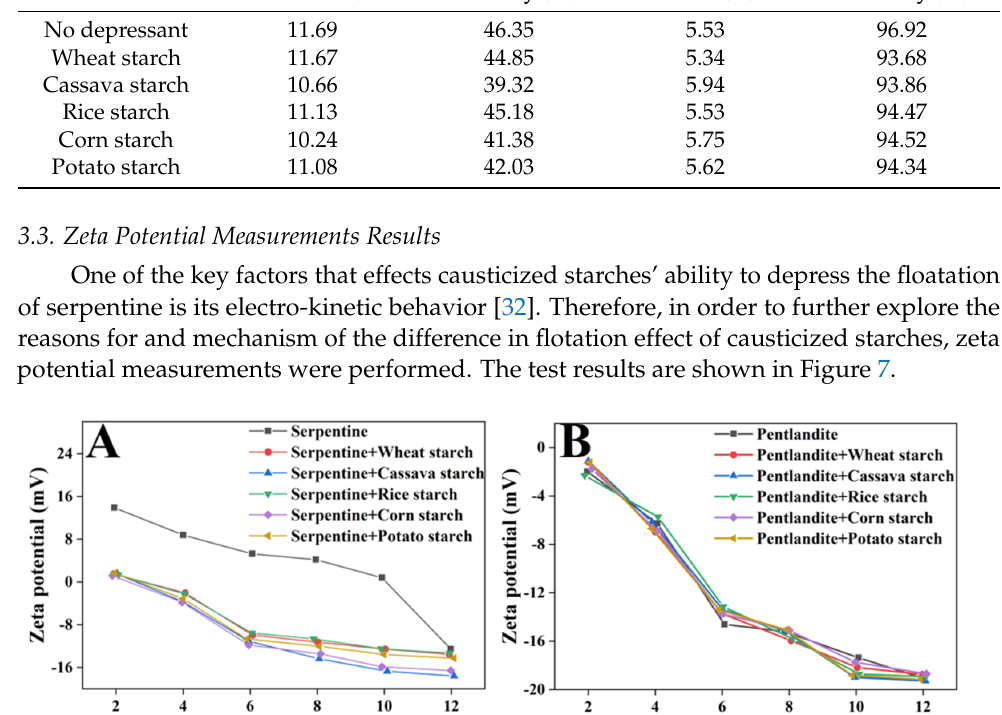
Table 2. Flotation separation of mixed mineral with different causticized starch depressants.